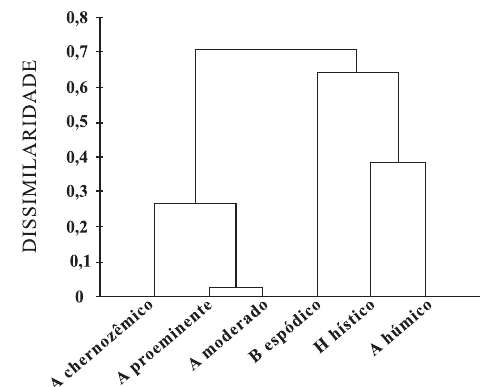
Figura 3. Dendograma obtido pelo método de APIP (agrupamento pareado igualmente ponderado) e dissimilaridade de Pearson (medida de